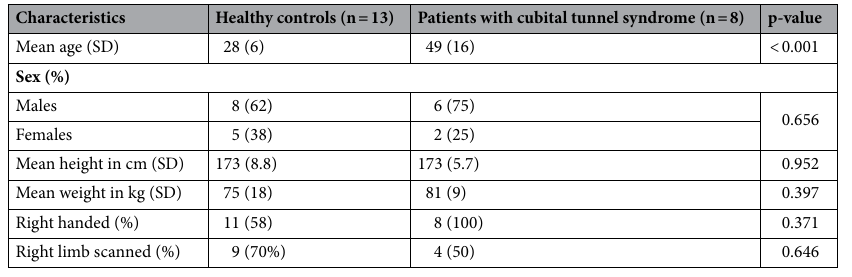
Table 1. Baseline characteristics.